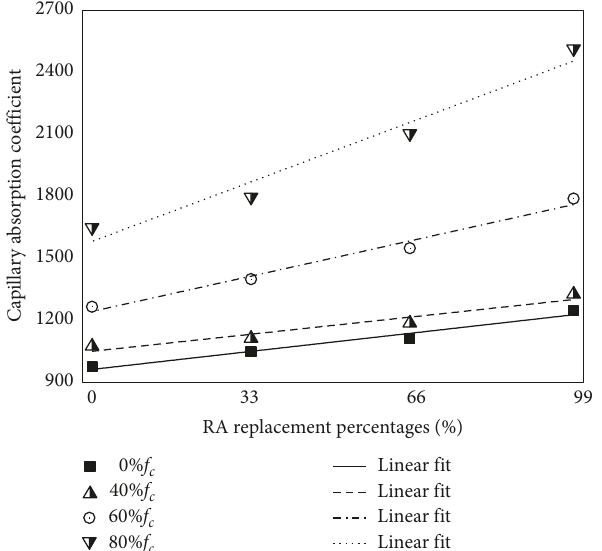
Figure 11: Relationship between capillary absorption coefficient and RCA replacement percentages.